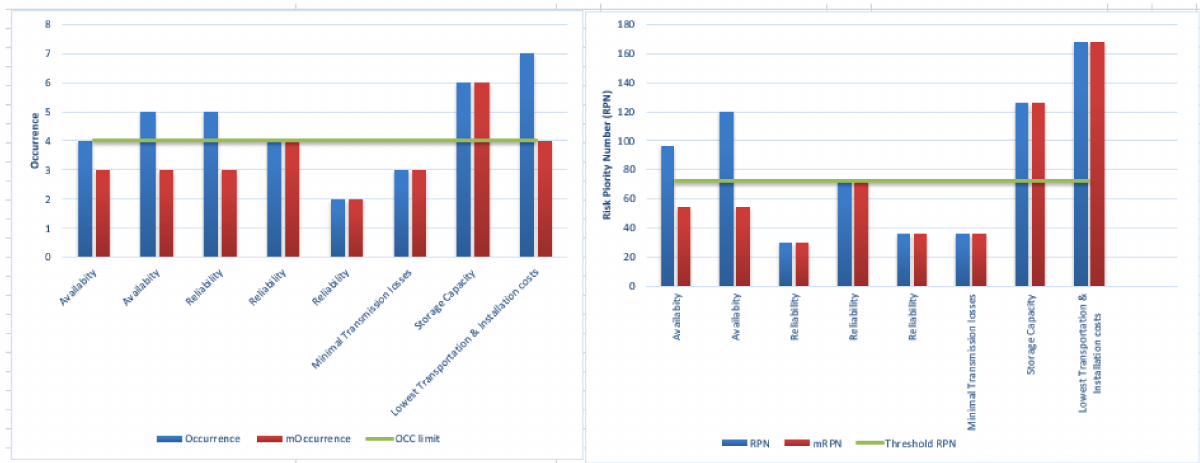
Figure 5. Example showing: ( left )—the functional requirement occurrences and mitigated occurrences against occurrence limit of 4; ( right )—RPNs and mitigated RPNs against threshold RPN of